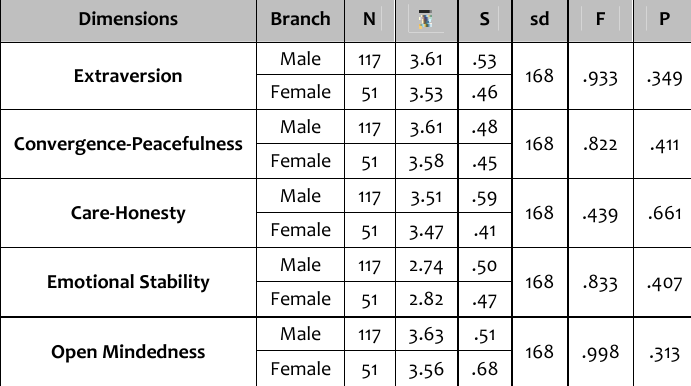
Table 4. t Test for Gender Variable Differentiation of Personality Traits Scores Average of the Visually Impaired Athletes Participate in the Study Dimensions